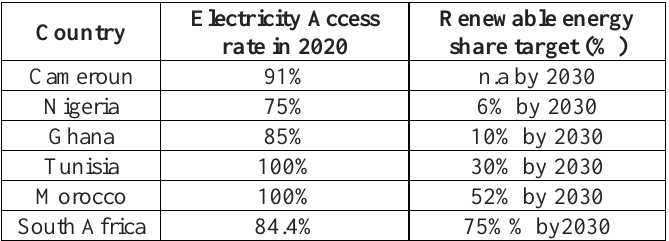
Table1: Electricity Access by Country (Cameroun., Nigeria, Ghana, Tunisia, Morocco, and South